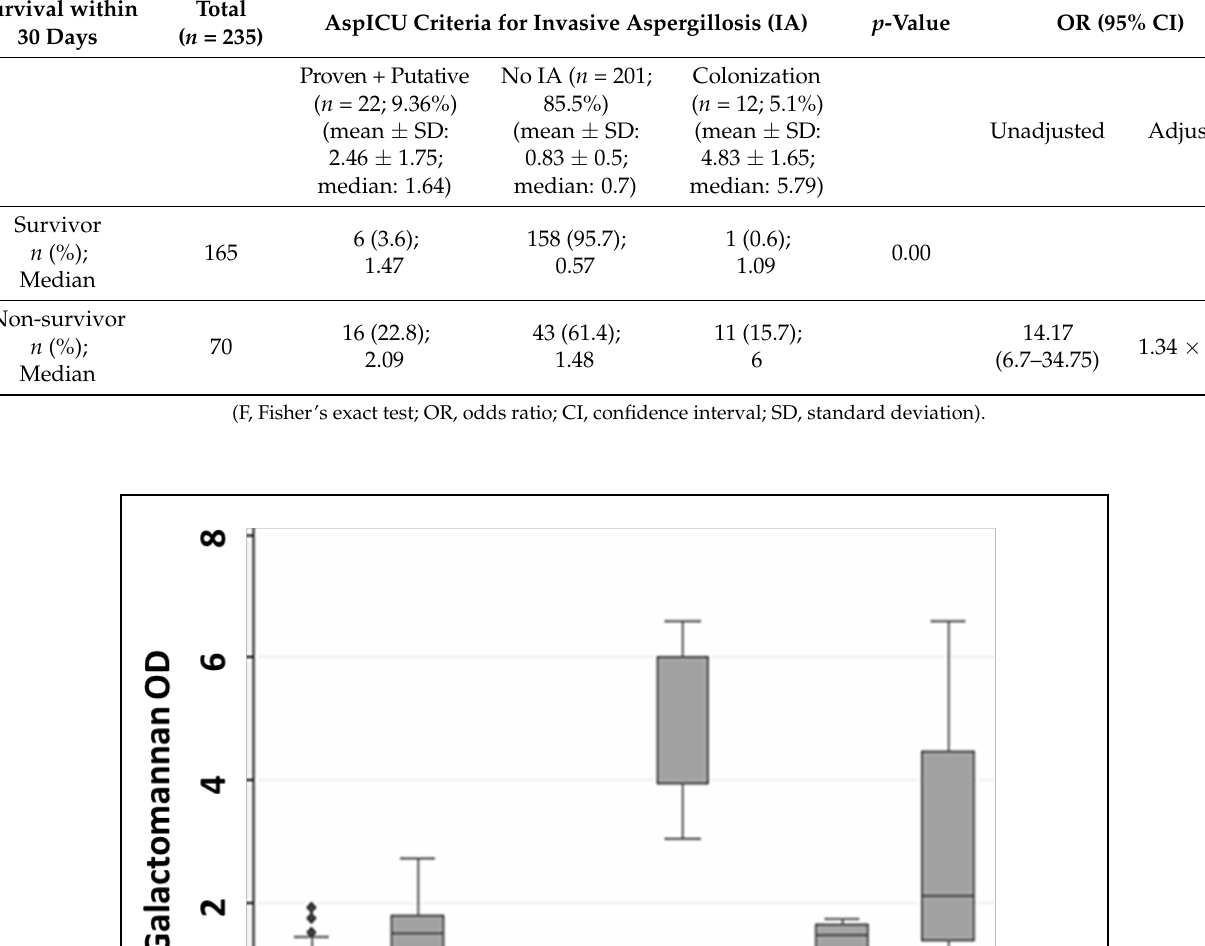
Table 3. Galactomannan values using AspICU diagnostic criteria and the outcomes.